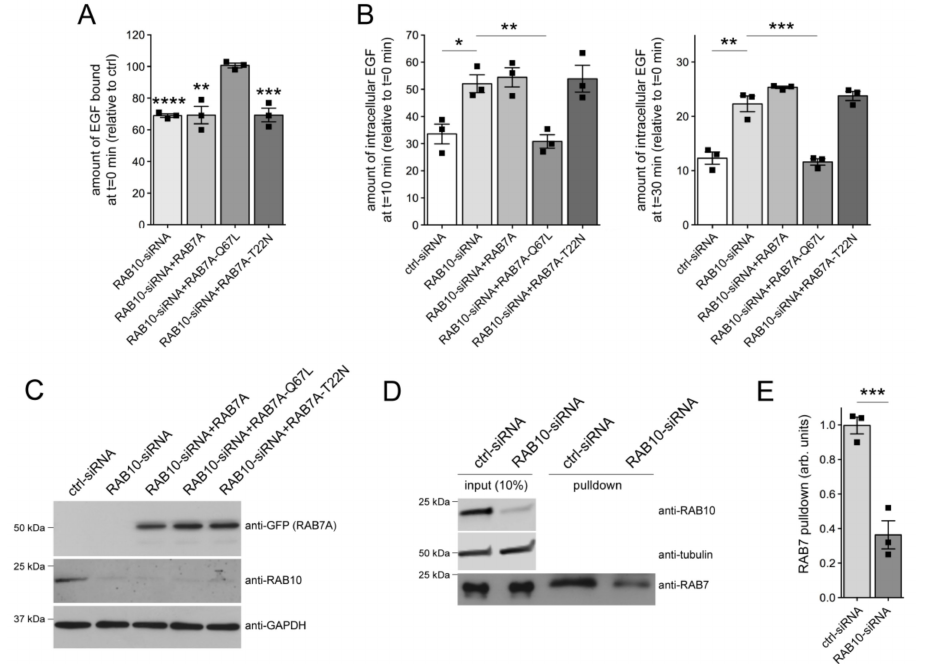
Figure 3. Knockdown of RAB10 decreases RAB7 activity. ( A ) HeLa cells were either transfected with ctrl-siRNA, or with RAB10-siRNA in the absence or presence of GFP-tagged RAB7A constructs as indicated, and surface-bound fluorescent EGF was quantified. N = 3 independent experiments. ** p < 0.01; *** p < 0.005; **** p < 0.001. ( B ) Cells were either transfected with ctrl-siRNA, or with RAB10-siRNA in the absence or presence of GFP-tagged RAB7A constructs as indicated, and internalized fluorescent EGF was quantified at 10 min (left) and 30 min (right) upon internalization. N = 3 independent experiments. * p < 0.05; ** p < 0.01; *** p < 0.005. ( C ) Cells were treated with ctrl-siRNA or RAB10-siRNA, and transfected with the indicated RAB7A constructs, and cell extracts (30 µ g) were analyzed by Western blotting for GFP-RAB7A protein levels, endogenous RAB10 protein levels, and GAPDH as loading control. ( D ) Cells were either treated with ctrl-siRNA or RAB10-siRNA. The RAB7-binding domain of RILP coupled to GST was used to pull down the GTP-bound form of RAB7 from cell lysates (300 µ g), and 10% of input was run alongside pulldowns to show equal levels of total RAB7 protein in ctrl-siRNA or RAB10-siRNA-treated cells. The levels of RAB10 and tubulin were analyzed on a separate gel. ( E ) Quantification of the type of experiments is depicted in ( D ), with the amount of RAB7 isolated by GST-RILP expressed relative to input. N = 3 independent experiments. *** p <